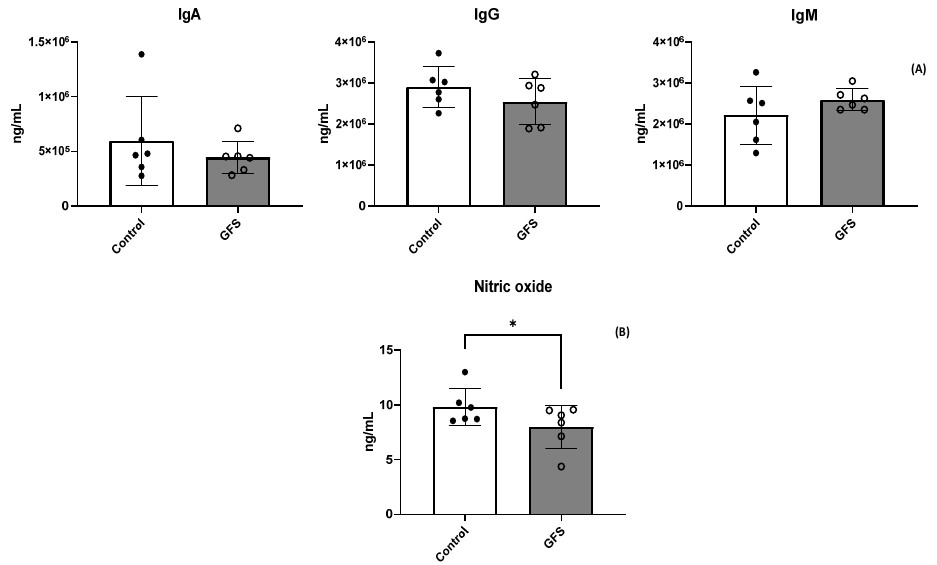
Figure 1. Effect of GFS diet on selected immune markers in the plasma of weaned piglets. ( A ) Con- centration of immunoglobulins IgA, Ig G and Ig A in the plasma of control (white columns) and GFS-treated (grey columns) piglets. ( B ) Concentration of nitric oxide in the plasma of control (white columns) and GFS-treated (grey columns) piglets. The results are displayed as mean ± standard error (SE). * indicates a significant difference between control and GFS-treated piglets ( p < 0.05).